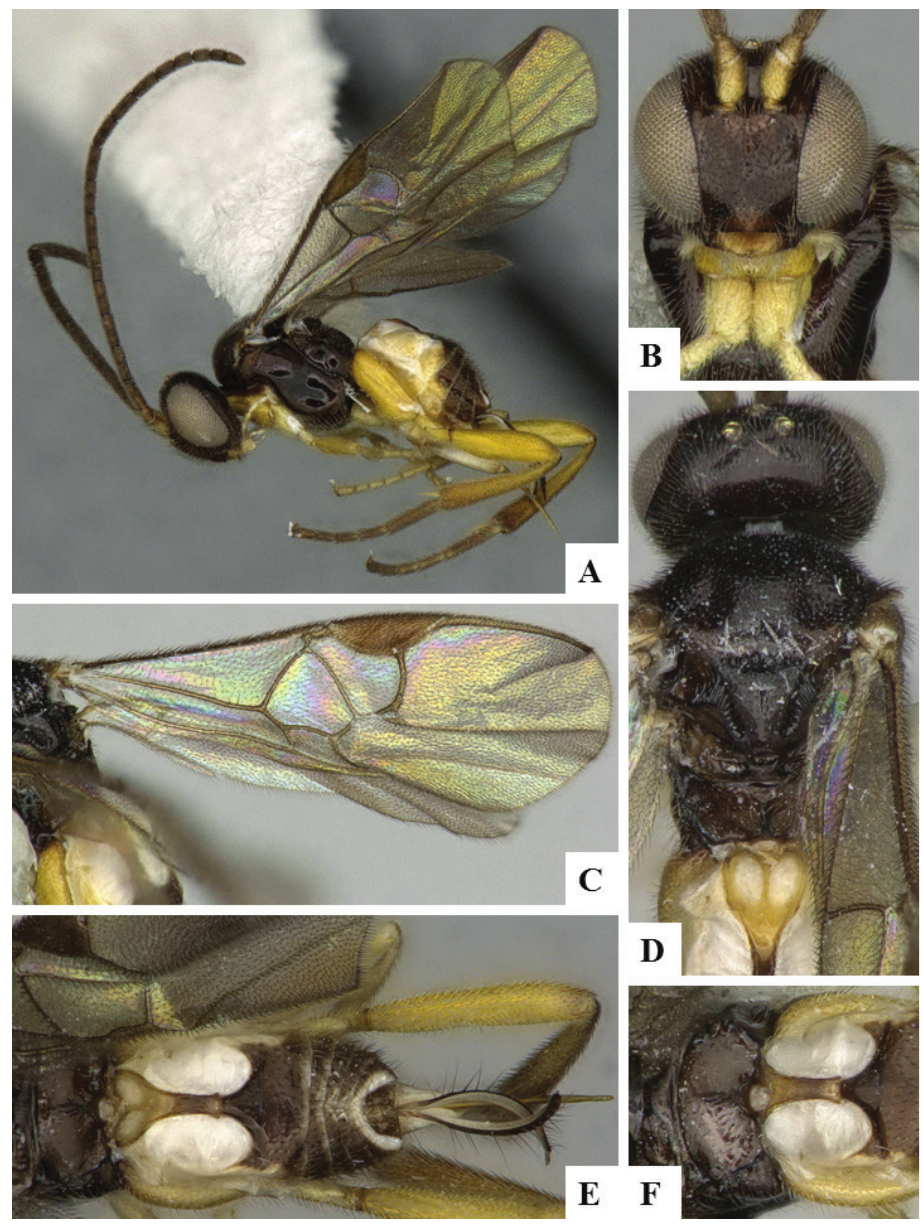
Figure 11. Billmasonius cienci female holotype. A Habitus B Head frontal C Fore wing D Head, meso- soma and tergite 1, dorsal E Metasoma dorsal F Propodeum and Tergites 1 to